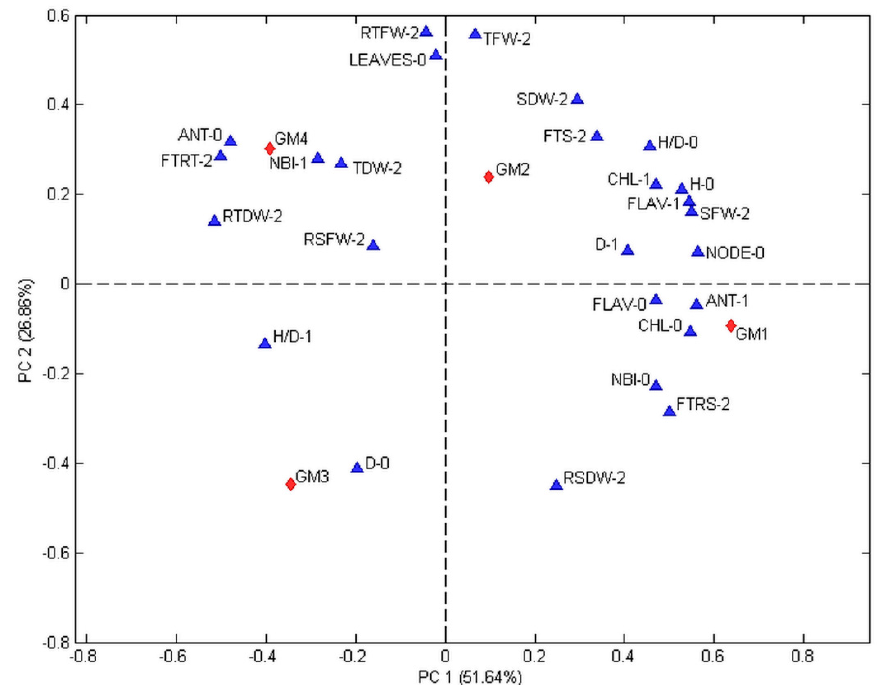
Figure 2. Ordination biplots of principal component analysis outputs of the data from bare-rooted vines grown on growing media (GM) containing composted solid digestate (CSD) at different rates. GM1 = commercial peat (CP) 100%; GM2 = CP 90% + CSD 10%; GM3 = CP 80% + CSD 20%; GM4 = CP 60% + CSD 40%. Labels in the triangles indicate the investigated parameters: Leaf chlorophyll content (CHL); leaf flavonoid content (FLAV); nitrogen balance index (NBI); leaf anthocyanins (ANT); plant height (H); height diameter ratio (H/D); shoot fresh weight (SFW); rootstock fresh weight (RSFW); root fresh weight (RTFW); total fresh weight (TFW); shoot dry weight (SDW); rootstock dry weight (RSDW); root dry weight (RTDW); total dry weight (TDW); fraction to shoot (FTS); fraction to rootstock (FTRS); fraction to root (FTRT). 0 = parameter recorded at 170 day of year (DOY); 1 = parameter recorded at 275 DOY; 2 = parameter recorded at 362 DOY.